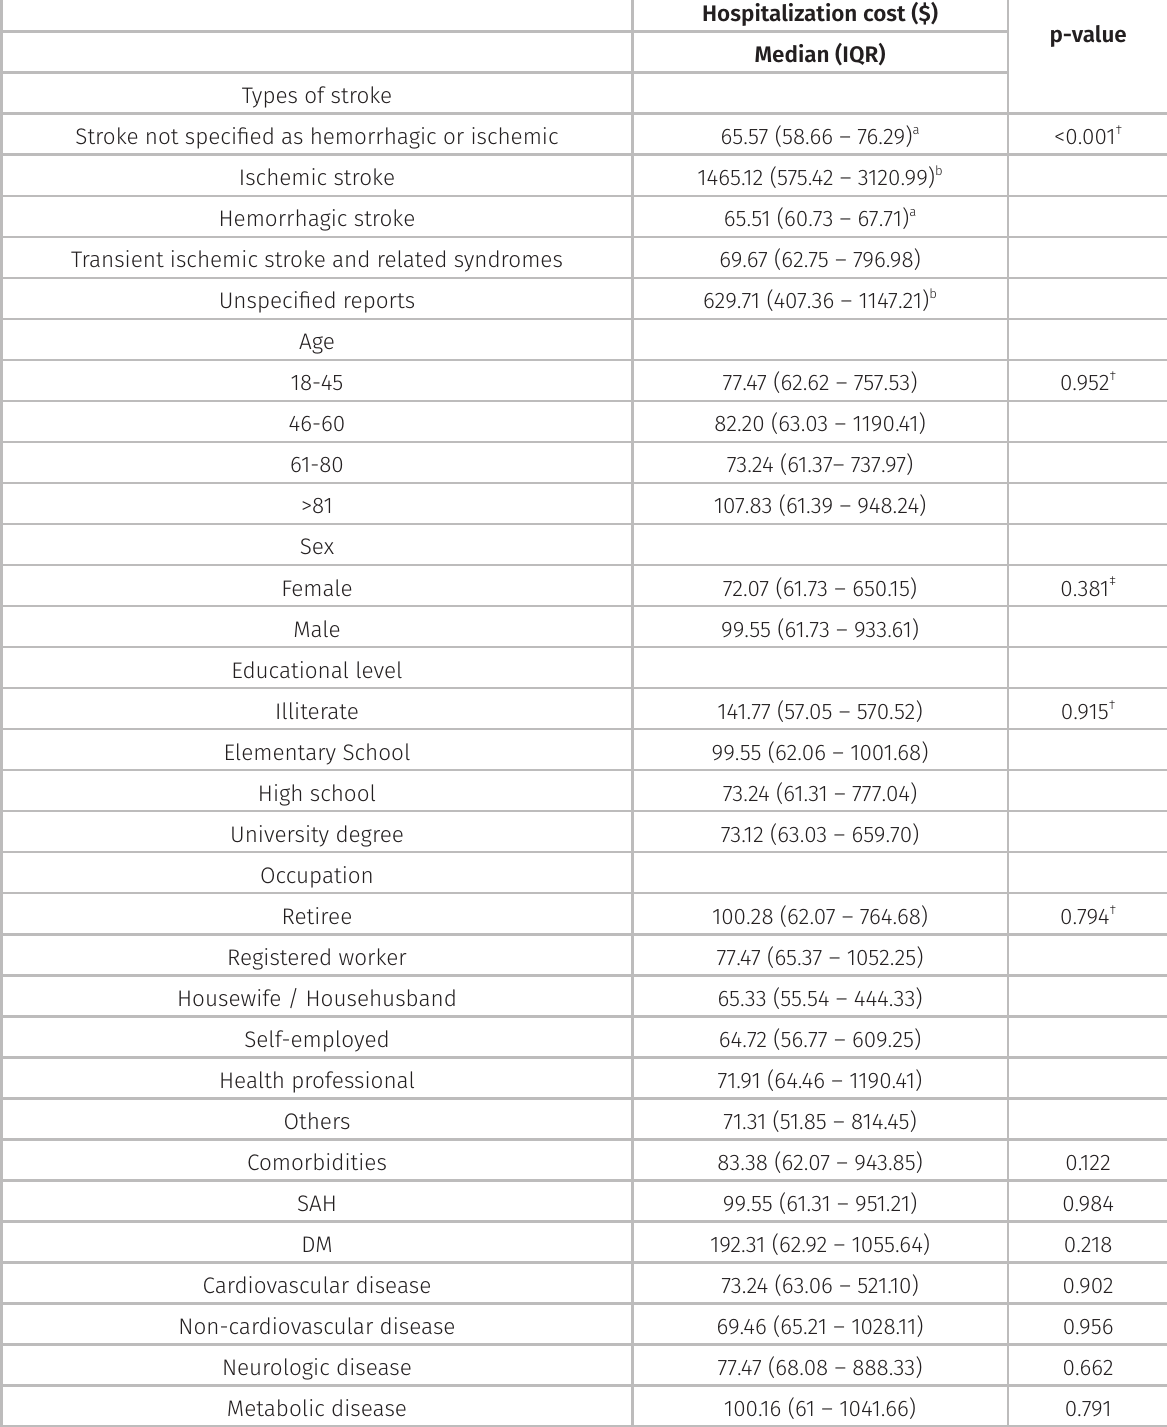
Table III. Hospitalization costs characteristics in adult population admitted by stroke diagnosis in a private hospital in southern